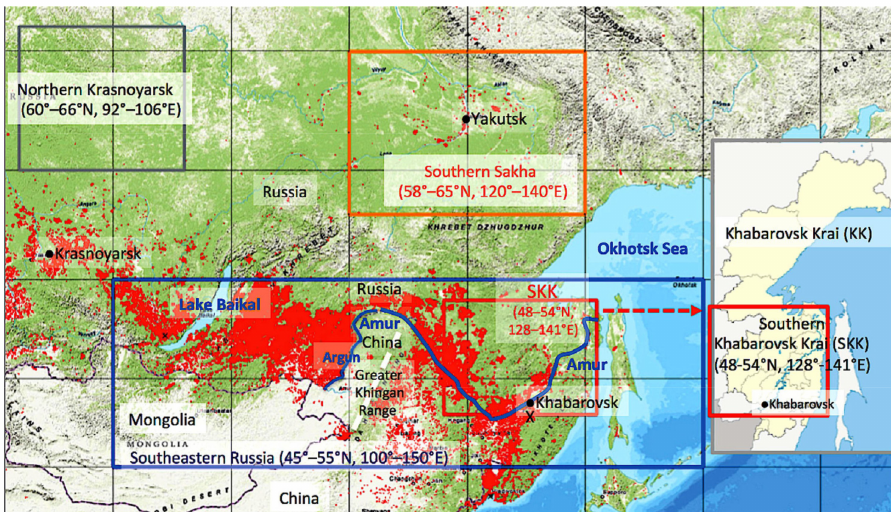
Figure 1. Map of the study region and other reference study regions in eastern Siberia and Khabarovsk Krai (SKK) [8,16,17]. The study region (48–54 ◦ N, 128–141 ◦ E, shown by the red rectangle) in the southern Khabarovsk Krai (SKK). Southeastern Russia (45 ◦ –55 ◦ N, 100 ◦ –150 ◦ E) is shown by the blue rectangle [8]; the southern Sakha (58 ◦ –65 ◦ N, 120 ◦ –140 ◦ E) is shown by thee orange rectangle [16,17]; the northern K (60 ◦ –66 ◦ N, 92 ◦ –106 ◦ E) is shown by the grey rectangle [17]; hotspots from March to June 2003 are shown by red dots; ‘X’: the wind reference site (48 ◦ N, 135 ◦ E); Amur: the Amur River is shown by blue line; the Greater Khingan Range is shown by the light yellow dotted line; Base map from LandsatLook Viewer website